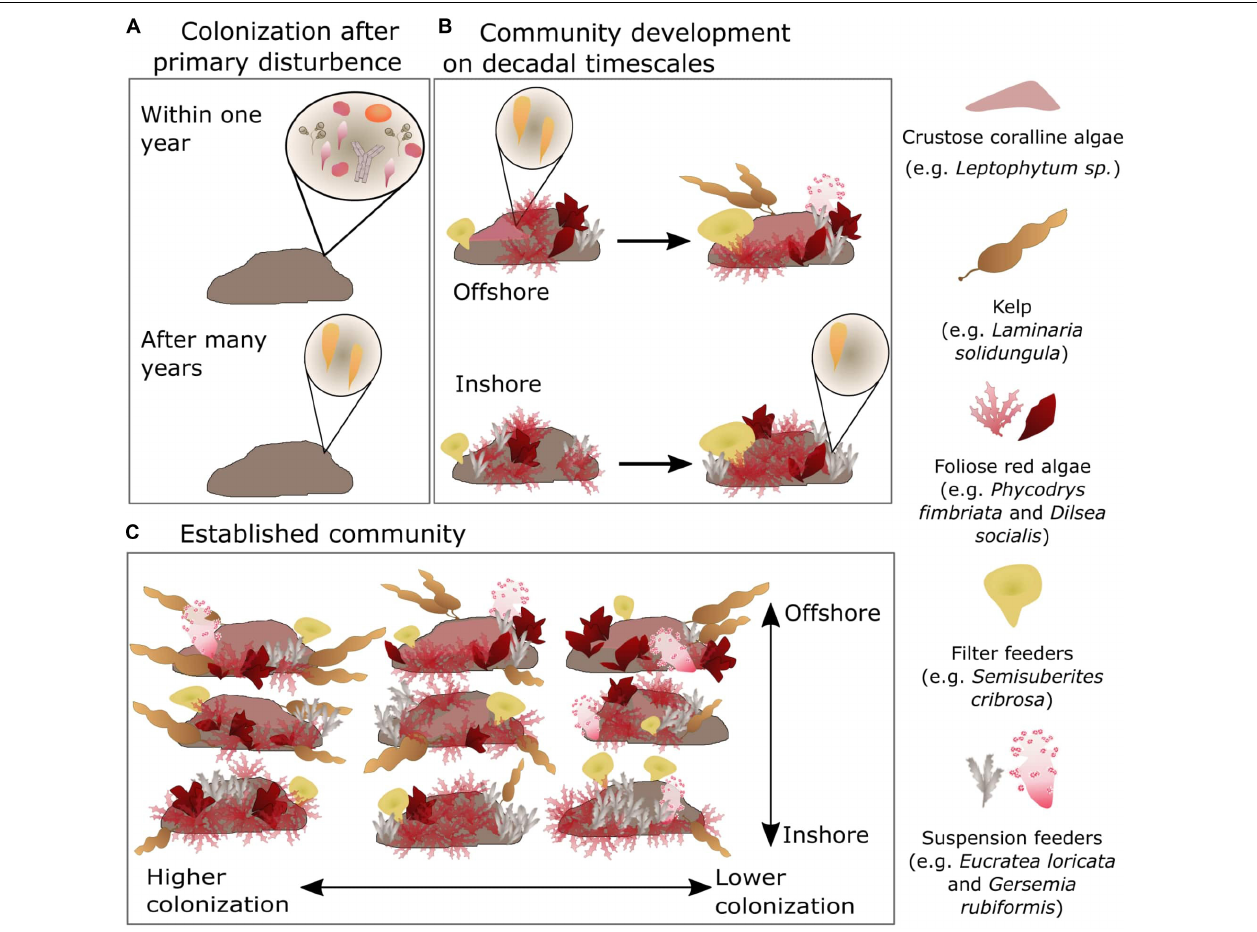
FIGURE 8 | Theorized process by which location and relative colonization rate determine community structure across scales in the Boulder Patch. (A) All functional groups except for kelp colonize primary substrate within 1 year. (B) Slow growth rates reflect pulse events, like freshwater intrusion at inshore sites, can prevent establishment of sensitive taxa (e.g., CCA). (C) Community structure at landscape scales depends on inshore/offshore location and relative rate of colonization compared to rate of primary